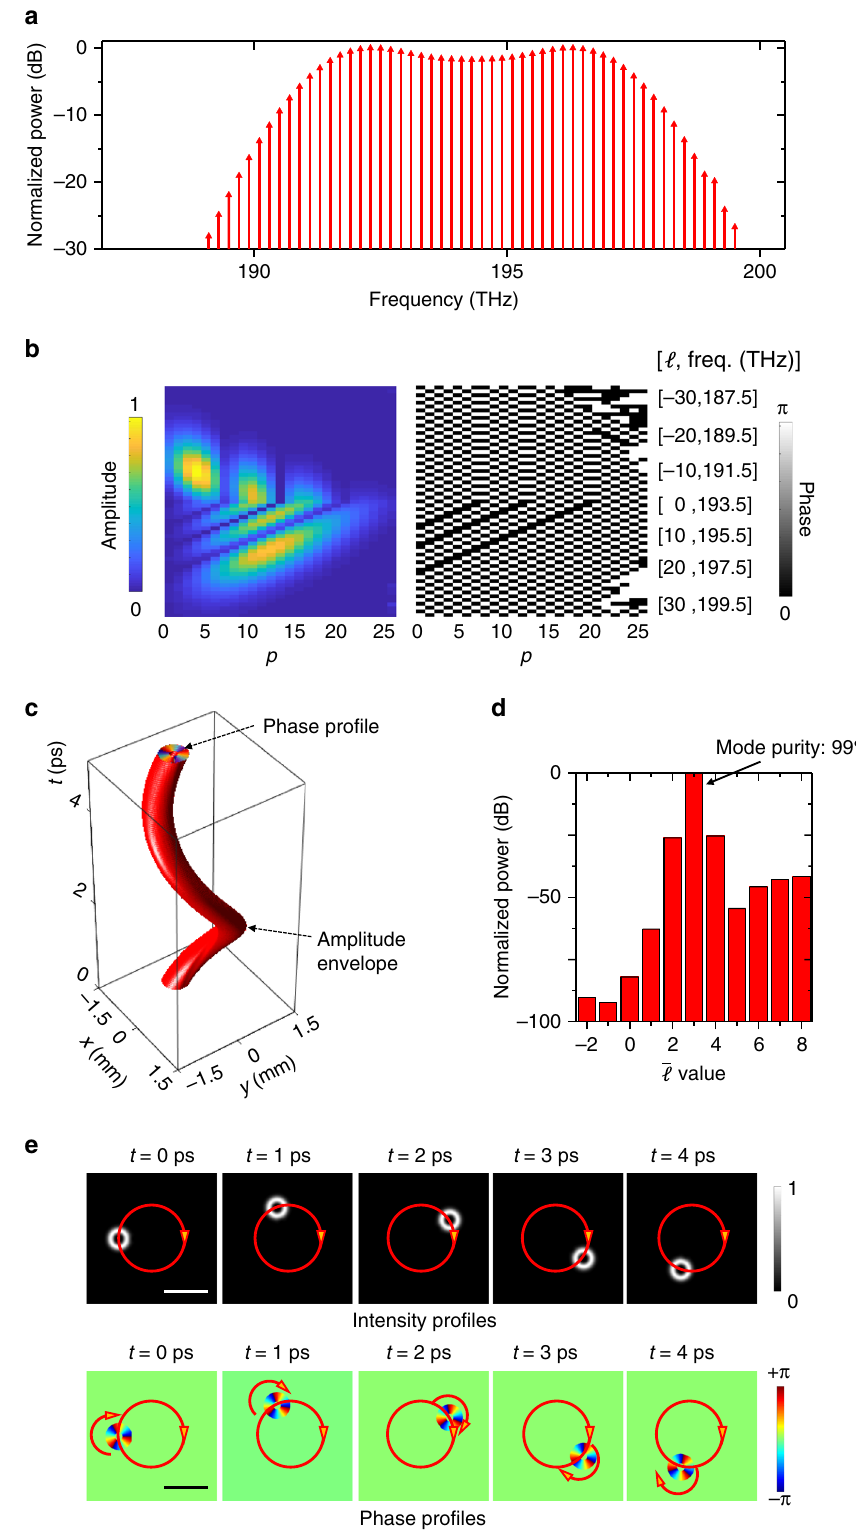
Fig. 3 Simulation results of a spatiotemporal beam exhibiting both rotation and revolution at a given distance. For the generated rotating-revolving LG 3,0 beam revolving at 0.2THz, we simulate its a frequency spectrum; b spatial LG ‘; p mode distribution, namely the amplitude and phase of the complex coef fi cients C ‘; p of all the LG ‘; p modes used for superposition; c envelope structure (i.e., the iso-surface with an amplitude of 1/10 of the peak value), where the top cap represents the helically twisting phasefront; d power distribution on light beams with different rotating (cid:1) ‘ values; and e dynamically rotating and revolving intensity/phase pro fi les. Scale bar, 1mm. The spatiotemporal beam consists of multiple frequency comb lines, in which each line is a superposition of multiple LG ‘; p modes (same beam waist of 0.3 mm) with one ‘ value but multiple p values. The dynamic helical phasefront and envelope indicate that the beam not only rotates around its beam center but also revolves around another central axis 0.75 mm away from its center. freq.: